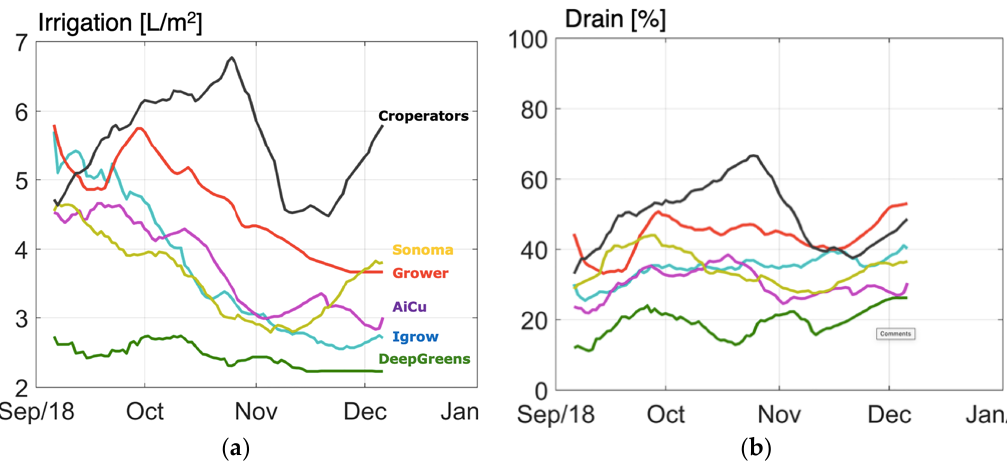
Figure 12. Course of irrigation water supply ( a ) and drain percentage ( b ) in different compartments during the cucumber experiment.